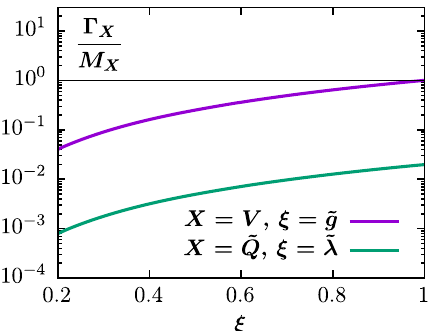
Fig. 4 Ratio of mediator width (cid:8) X to mediator mass M X for the two cases of a spin-1 mediator V in the s -channel model (solid purple) and a scalar mediator ˜ Q in the t -channel model (dashed green), as a function of the corresponding coupling ( ξ = ˜ g or ξ = ˜ λ ). The parameters are = 3 TeV, and m χ = 100 fixed to M V = 10 TeV, M ˜ Q